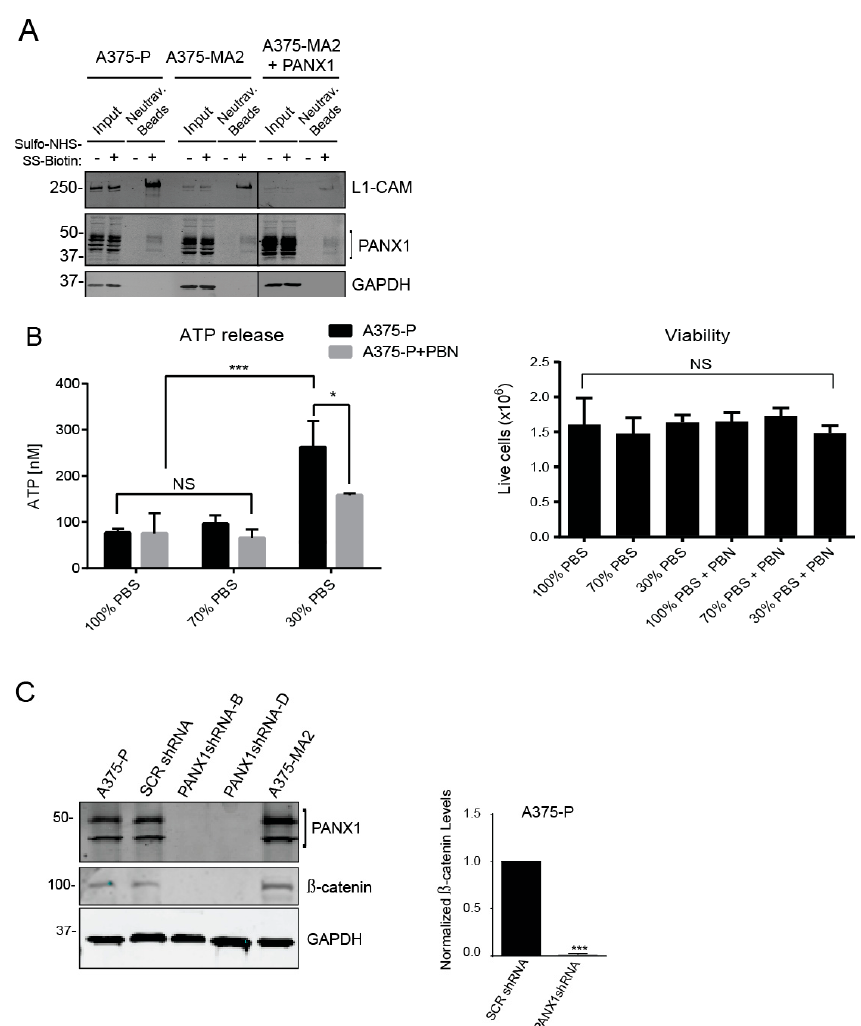
Figure 7. Inhibition of PANX1 alters the signaling profile of melanoma cells. ( A ) Protein lysates from A375-P, A375-MA2 cells with endogenous expression of PANX1 as well as A375-MA2 cells overexpressing PANX1 were used for cell-surface biotinylation assays. Negative controls were prepared in parallel in absence of biotin labeling reagent. Western blotting for L1-CAM and GAPDH were used as positive control of cell surface protein and control for non-specific biotinylation of intracellular/cytoplasmic proteins, respectively. Only a fraction of PANX1 is localized to the cell surface of cells examined in this experiment. ( B ) A375-P cells were washed in PBS and incubated with appropriate isotonic solution for 5 min (100% PBS (control), 70% PBS or 30% PBS) in the presence of 1 mM PBN. There was a significant decrease in ATP released into the culture medium in the presence of 1 mM PBN. Plotted values are means ±S.D. * p < 0.05, *** p < 0.0005 as determined by a two-way ANOVA with a Tukey’s multiple comparisons test. Viable cells were counted after each treatment and plotted in the right panel. There was no significant difference in the number of live cells in each treatment condition. ( C ) A375-P cells were transfected with either scrambled shRNA (SCRshRNA) as a control or two different shRNA construct against PANX1 (PANX1shRNA -B and -D). Cells were lysed, and equal amounts of protein were resolved by 12% SDS-PAGE. Western blot analysis using polyclonal antibodies confirmed PANX1 knockdown. GAPDH was used as loading control. There was a significant reduction in the abundance of β -catenin in PANX1 knockdown cells. Cell lysates of non-transfected A375-P and A375-MA2 cells were used as additional controls in the experiments. Graph depicts the quantification of western blots from three separate experiments, N = 3, student’s t -tests; *** p <